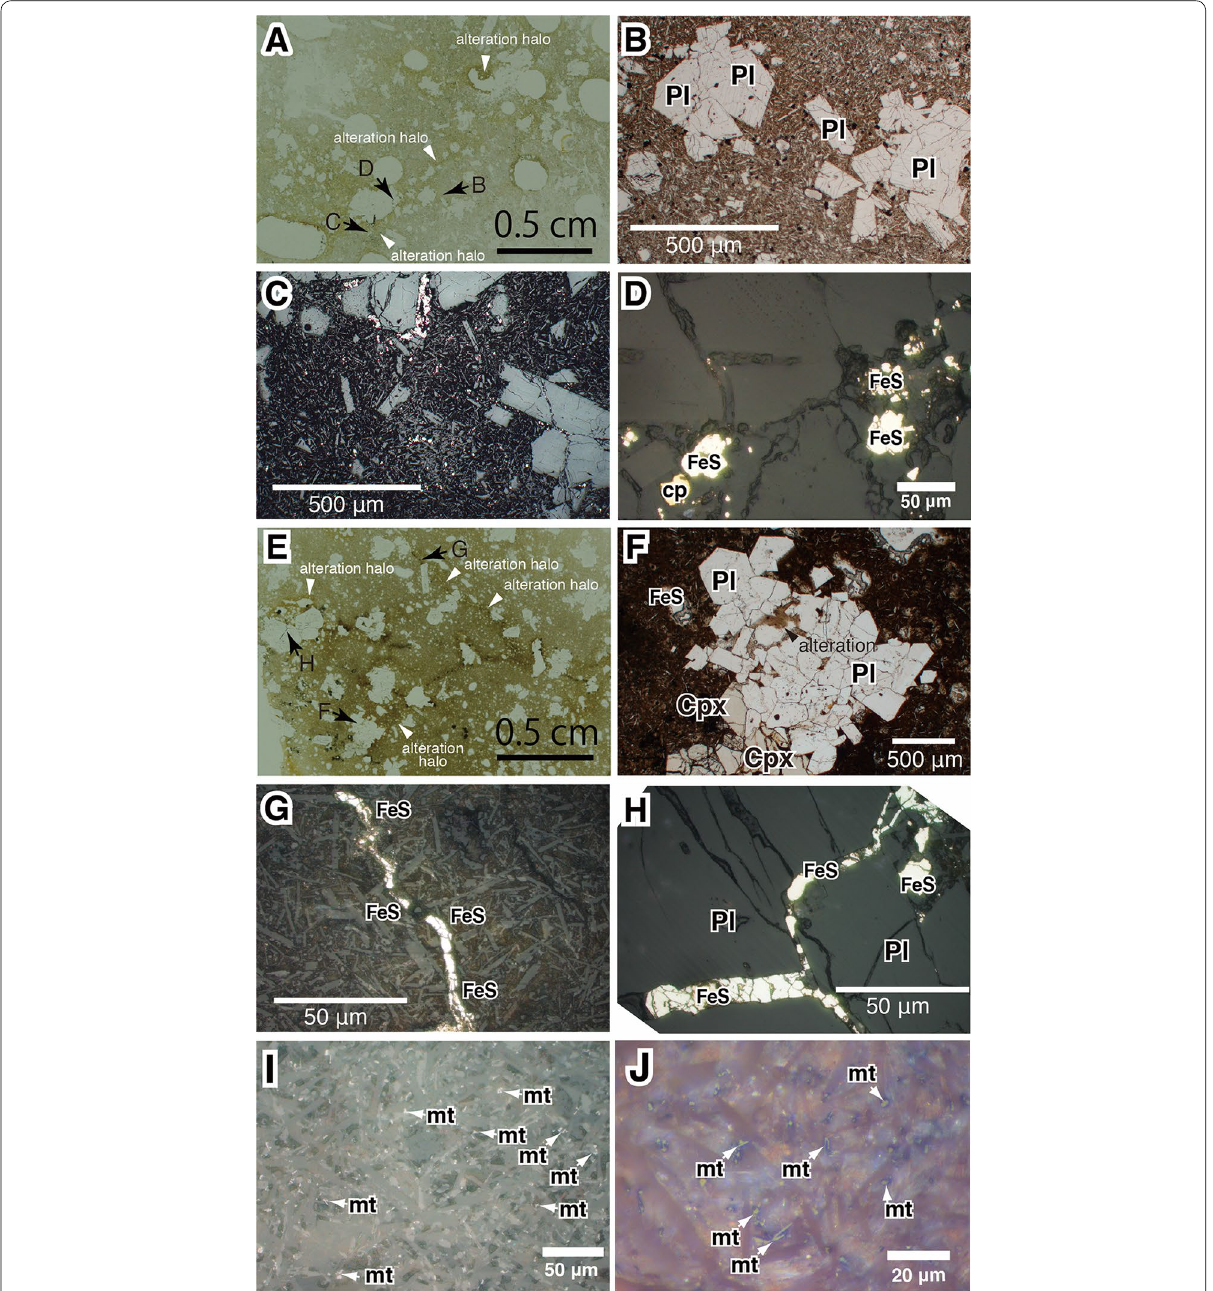
Fig. 4 Photomicrographs of the studied altered volcanic rock samples from the Irabu knolls of the Okinawa Trough: 6K#569R4‑1 and 6K#569R4‑3; A thin‑section image of 6K#569R4‑1 under transmitted reflected plane‑polarized light (PPL). Arrows in B , C , and D are approximate positions of the following photographs. B Plagioclase (Pl) glomeroporphyritic and intersertal groundmass texture in the 6K#569R4‑1. Small black minerals scattered within groundmass are pyrite. Under transmitted PPL. C Mode of occurrence of pyrite grains in the 6K#569R4‑1. All bright grains are pyrite grains. Under reflected PPL. D Pyrite (FeS) and chalcopyrite (cp) grains in the 6K#569R4‑1. Under reflected PPL. E Thin‑section image of 6K#569R4‑3 under transmitted PPL. Arrows in F , G , and H are approximate positions of the following photographs. F Plagioclase (Pl) and clinopyroxene (Cpx) glomeroporphyritic and intersertal groundmass texture in the 6K#569R4‑3. Plagioclase is partly altered. Under transmitted PPL. G Bright light yellowish pyrite grains form veinlet along fracture in groundmass of the 6K#569R4‑3. Under reflected PPL. H Bright light yellowish pyrite grains form veinlet along fracture in plagioclase (Pl) phenocryst of the 6K#569R4‑3. Under reflected PPL. I and J Titanomagnetite (mt) grains in the 6K#569R4‑3. Under reflected PPL ( J : oil